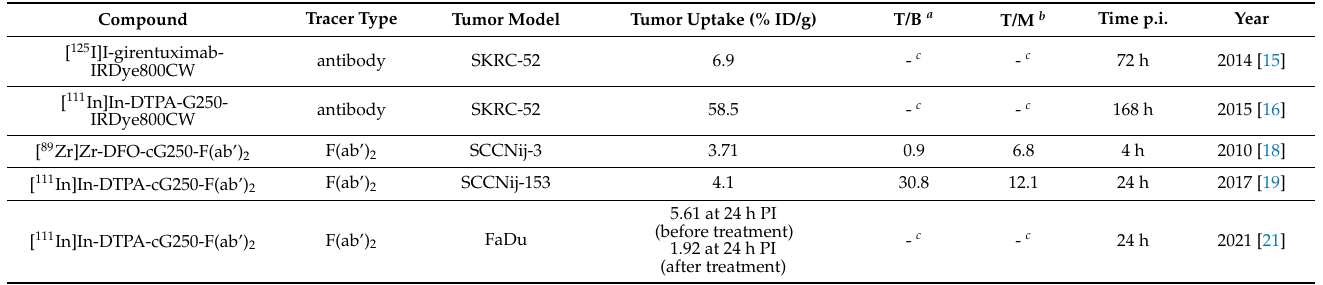
Table 1. Overview of the preclinical evaluation of radiolabeled, CAIX-targeted mAb and its fragments. Compound Tracer Type Tumor Model Tumor Uptake (% ID/g) T/B a T/M b Time